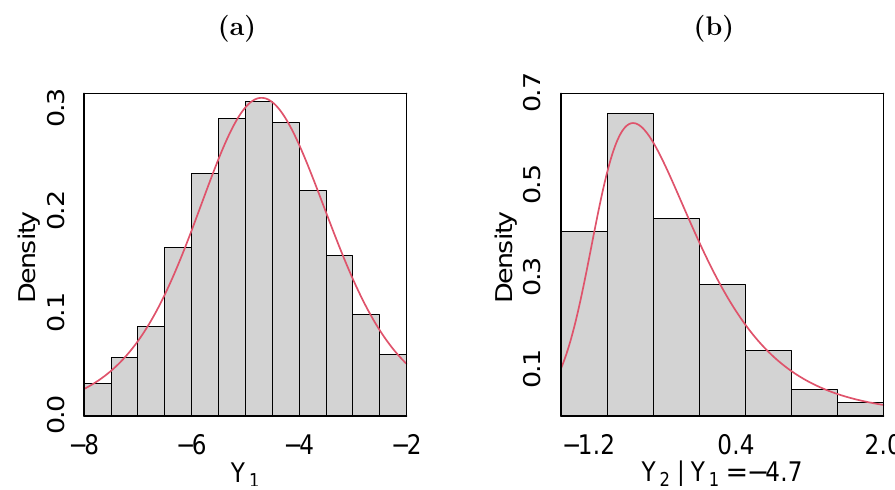
Figure 3. Histograms of simulated random samples from: ( a ) marginal distribution Y 1 overlaid with the PDF given in (11); ( b ) conditional distribution Y 2 | Y 1 = − 4.7 overlaid with the PDF established in Theorem